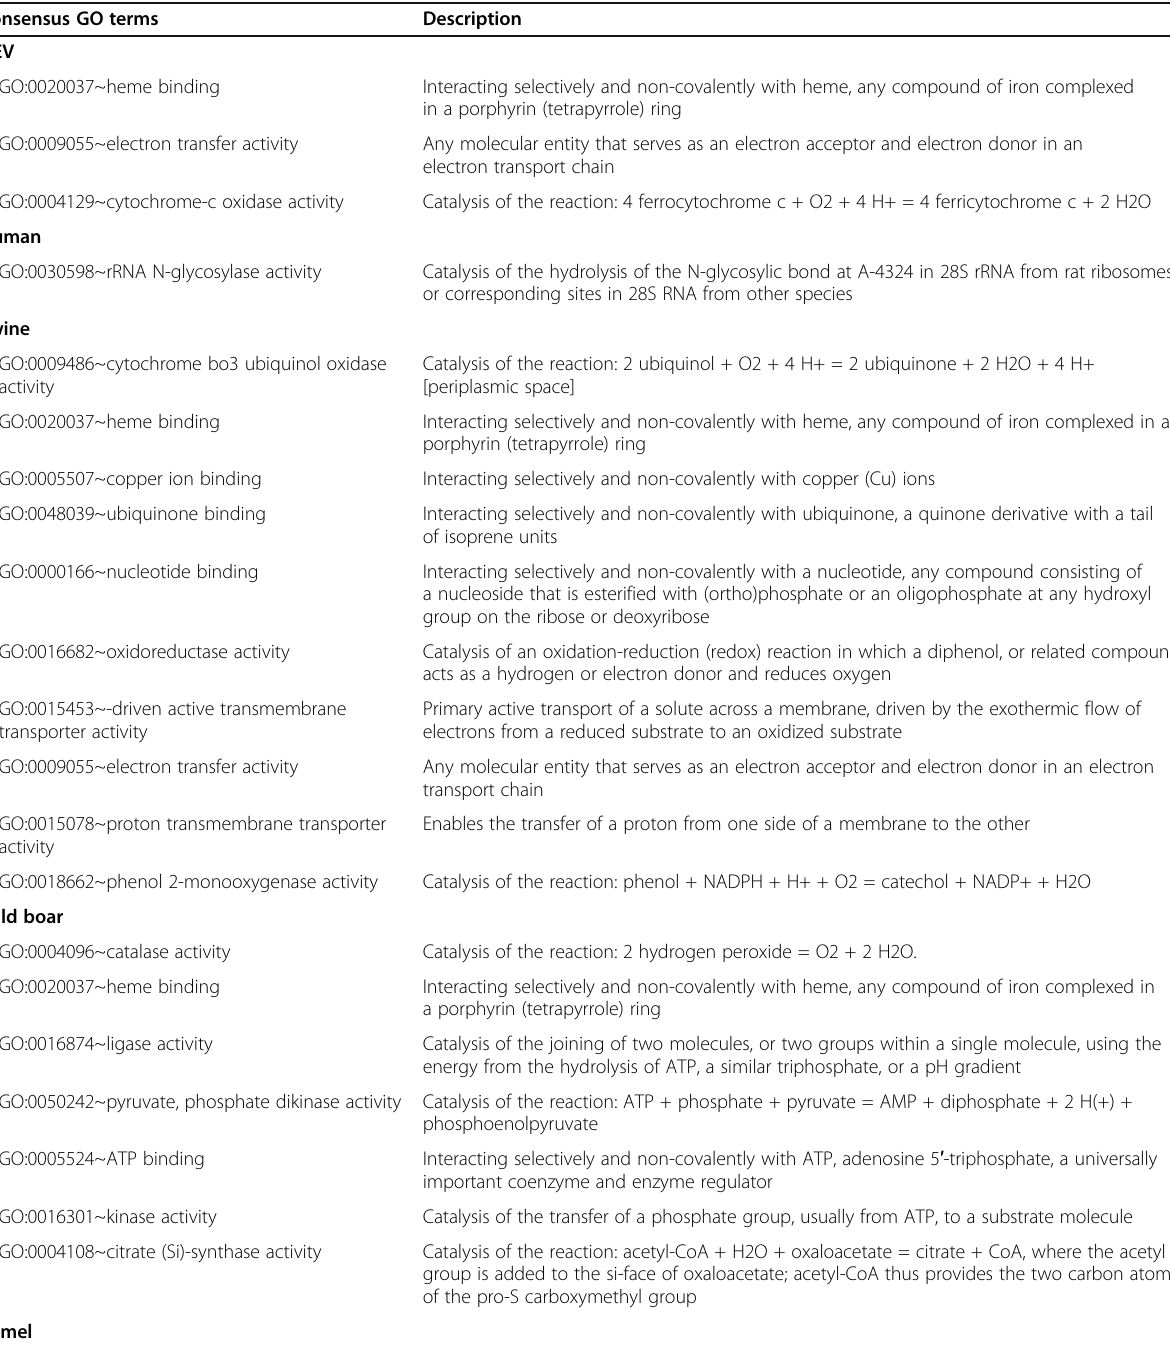
Table 4 Predicted consensus GO terms for YDR models Consensus GO